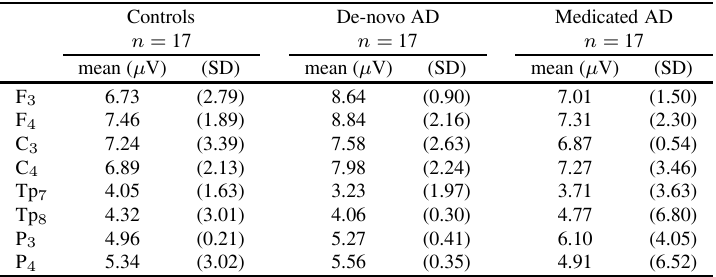
Maximum peak-to-peak amplitudes in auditory senory oscillatory responses in Alzheimer’sdisease(AD)andhealthyelderlycontrols(repeatedmeasuresofANOVA) ∗